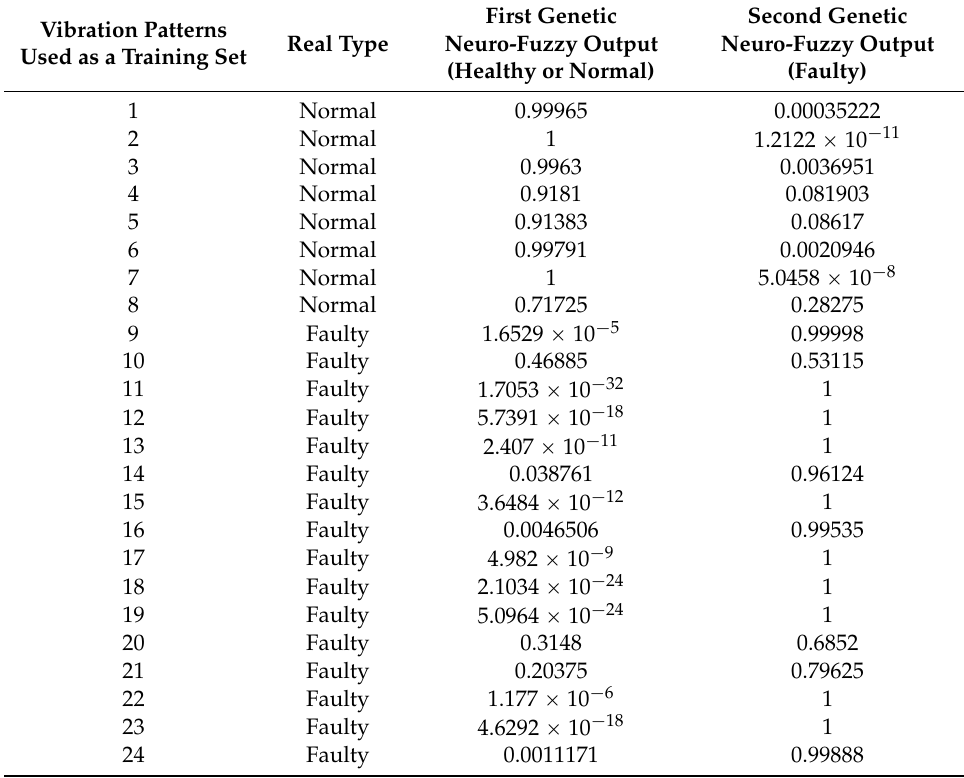
Table 1. Output values of the Genetic Neuro-Fuzzy system for the training set.